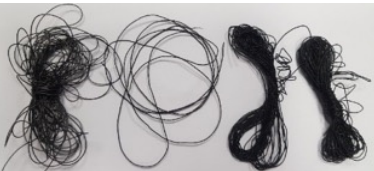
Figure 1. Coils of extruded composite fibers. From left to right, FGr (Gr/SBS), FCNT (CNT/SBS), FM1 (CNT/Gr/SBS), FM2 (CNT/Gr/SBS) are shown, respectively.